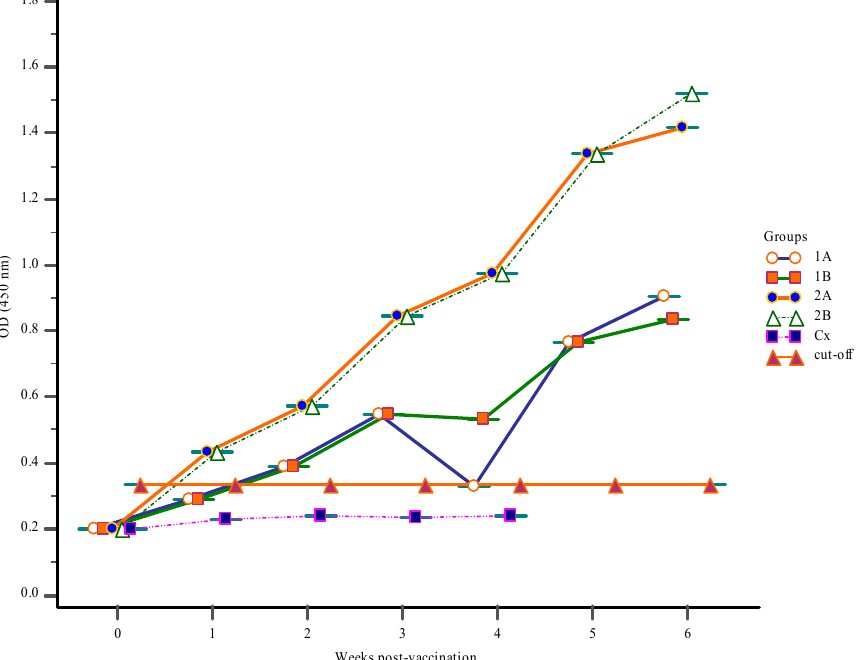
Figure 1. The serum IgM response following vaccination with a feed-based vaccine (1A, 1B, 2A, 2B) and control Group Cx. The first vaccination was done at 0-week post-vaccination (wpv) for groups (1A, 1B, 2A, 2B) with a 1st and 2nd booster vaccination given to Group 2B at 2- and 3-wpv, respectively. All groups were challenged with 10 6 CFU/mL live S. iniae via intra-peritoneum route at 4-wpv.